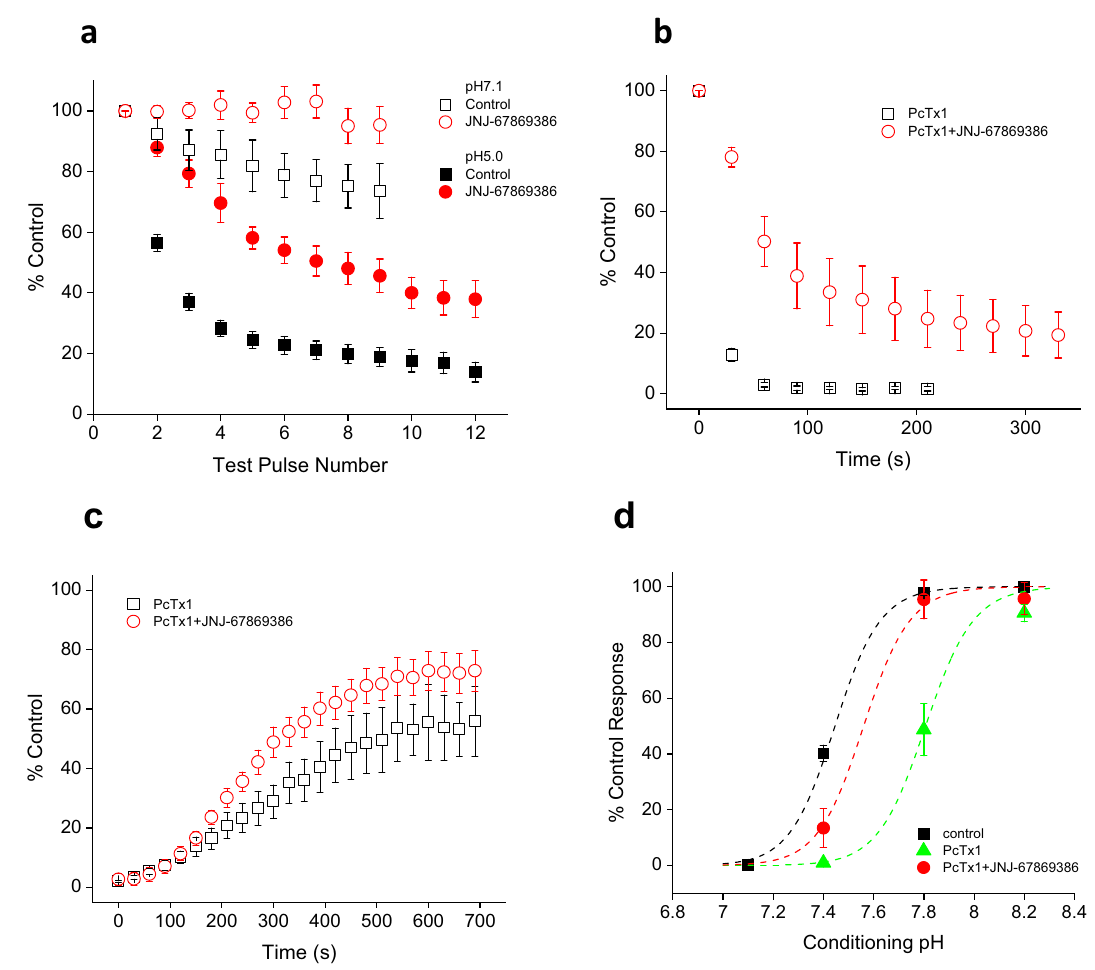
Fig. 7 Effect of JNJ-67869386 on tachyphylaxis and PcTx1-induced inhibition. a Conditioning pH 7.1-induced (open symbols) or pH 5.0-induced (solid symbols) induced tachyphylaxis in the absence (squares) or presence (in all pH buffers; circles) of 100 nM JNJ-67869386. Conditioning durations/Inter- pulse intervals are 60/120 s (pH 7.1 control; n = 7), 100/150 s (pH 7.1 JNJ-67869386; n = 6) and 14/60s (pH 5.0 control and JNJ-67869386; n = 12 each). Data for both pH 7.1 and pH 5.0 are statistically different between control and JNJ-67869386 ( p < 0.001). Data are normalized to the peak of pre- conditioning test pulse. Holding pH = 8.2. b Kinetics of current inhibition by PcTx1 (10 nM) in the absence (squares; n = 6) and presence (in all pH buffers; circles; n = 5; p < 0.001) of 100 nM JNJ-67869386. Holding pH = 7.4. c Kinetics of current recovery (wash) from PcTx1 (10 nM) inhibition in the absence (squares; n = 4) and presence (in all pH buffers; circles; n = 4; p < 0.001) of 100 nM JNJ-67869386. PcTx1 is removed at t = 0 s. Holding pH = 7.4. d pH dependence of steady-state desensitization in control (squares), 10 nM PcTx1 (triangles) or 10 nM PcTx1 + 100 nM JNJ-67869386 (circles; JNJ-67869386 in all pH buffers). Data are fi tted to a logistic function (dashed lines) with pH 50 values of 7.43 ± 0.01 (control; n = 14), 7.81 ± 0.02 (PcTx1; n = 4; p < 0.001 vs. control) and 7.56 ± 0.03 (PcTx1 + JNJ-6786386; n = 4; p < 0.001 vs. PcTx1 and p < 0.01 vs. control), respectively. All statistical tests are two- way